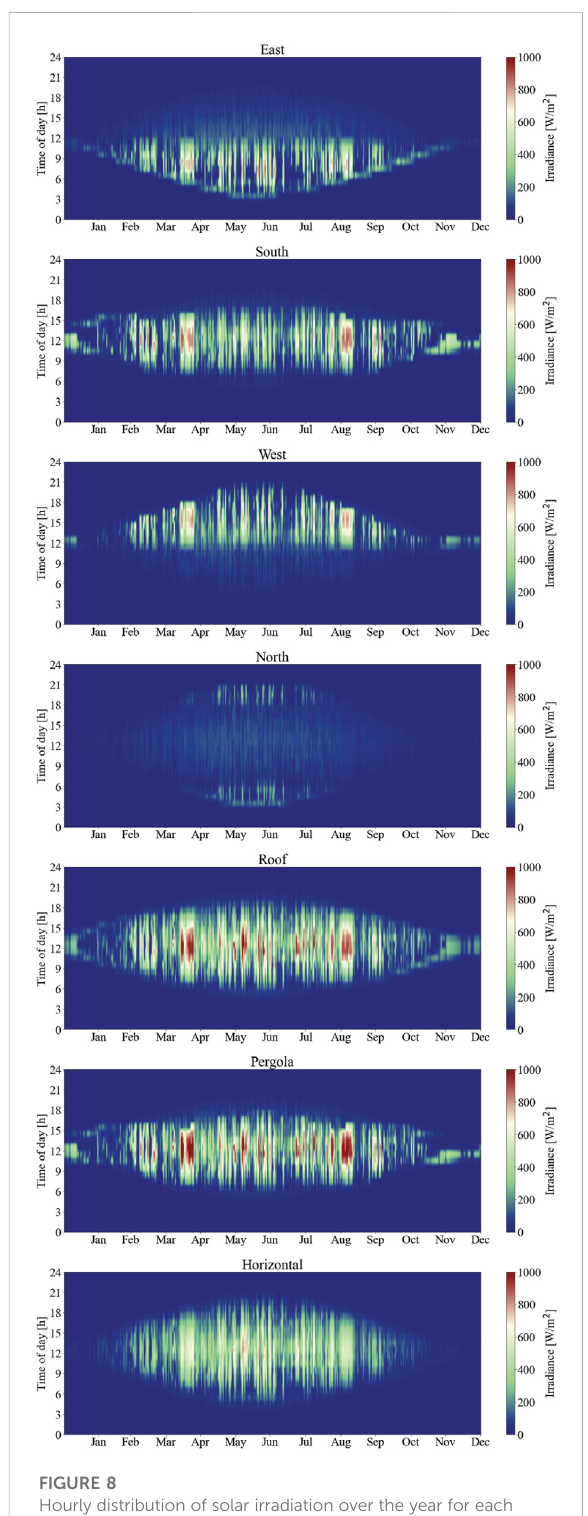
FIGURE 8 Hourly distribution of solar irradiation over the year for each